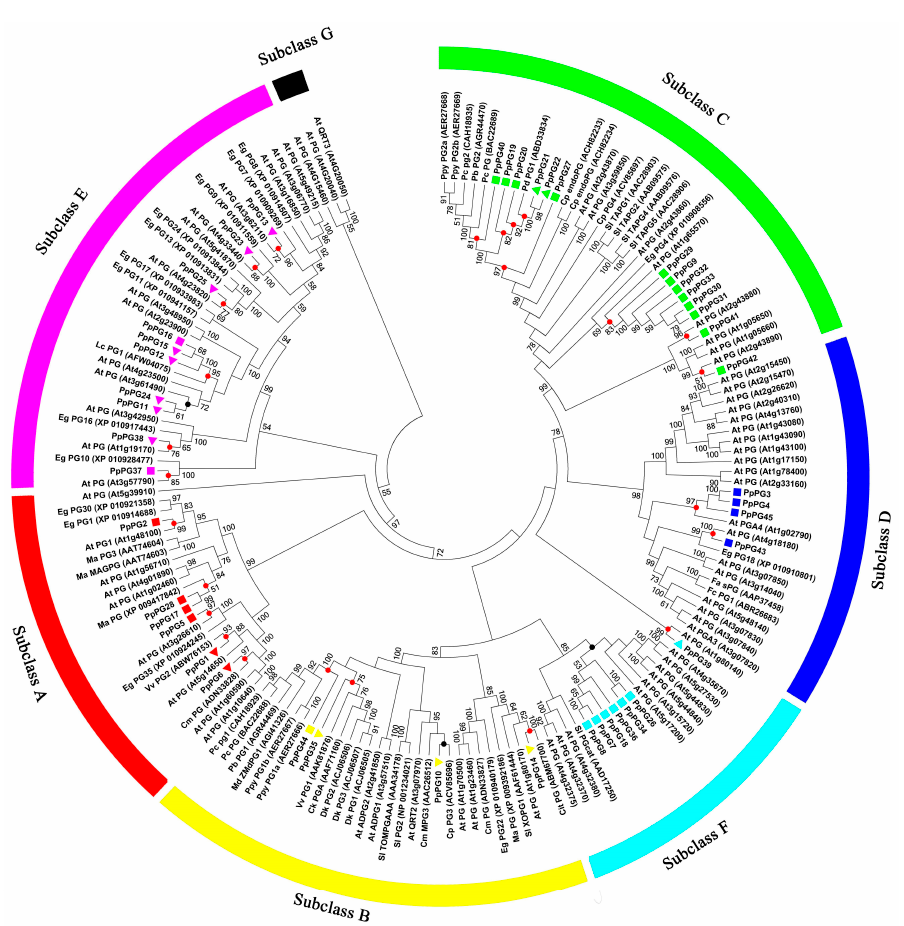
Figure 2. Phylogenetic tree of PGs from Prunus persica and other species. Species shown are Carica papaya (CpPG), Citrus sinensis (CitPG), Cucumis melo (CmPG), Diospyros kaki (DkPG), Fragaria chiloensis (FcPG), Arabidopsis thaliana (AtPG) , Fragaria × ananassa (FaPG), Actinidia chinensis (CkPGA), Litchi chinensis (LcPG), Malus domestica (MdPG), Musa acuminate (MaPG), Prunus domestica subsp. insititia (PdPG), Pyrus communis (PcPG), Pyrus bretschneideri (PbPG), Pyrus pyrifolia (PpyPG), Solanum lycopersicum (SlPG), Elaeis guineensis (EgPG) and Vitis vinifera (VvPG). Colored triangles and squares represent PpPGs and each color indicates a subclass; triangles indicate PpPG genes that are expressed in peach fruit and squares represent PpPGs that are not expressed in peach fruit according to results of RNA-seq. Red and black nodes indicate that the bootstrap support for the branches defining the common ancestral PGs is more than 50% and less than 50%, respectively. Bootstrap values lower than 50 are hidden in the unrooted phylogenetic tree.